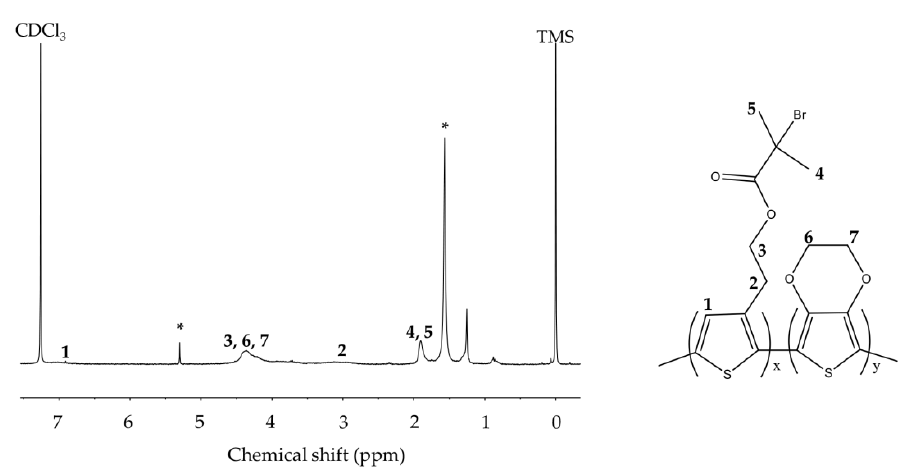
Figure 4. 1 H NMR spectrum of PEDOT-Br macroinitiator.